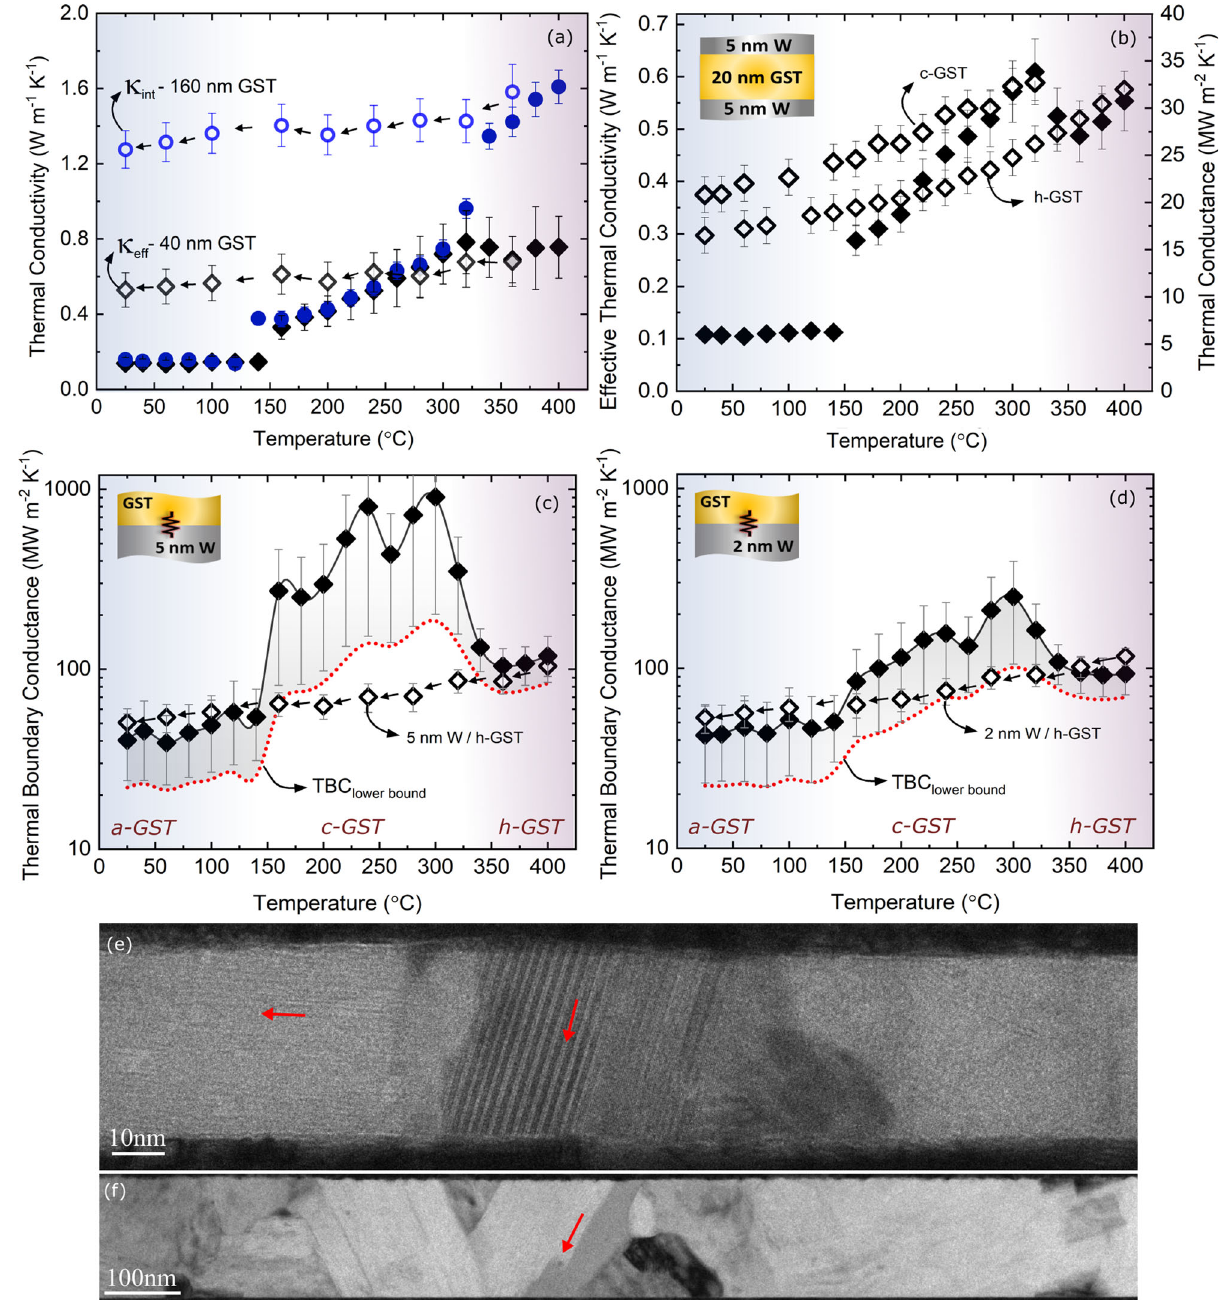
Fig. 3 Thermal properties of GST thin fi lms and interfaces across different phases. a Thermal conductivity of GST layer sandwiched between 5 nm W spacers for 40 nm (diamonds) and 160 nm (circles) GST fi lms. The solid symbols correspond to the thermal conductivity of GST as it transitions through different phases upon heating and hollow symbols correspond to the thermal conductivity of h-GST upon cooling. b Effective thermal conductivity for 20-nm-thick GST fi lm as a function of temperature across different phases of GST upon heating and cooling when annealed to 320 and 400 °C. c , d Thermal boundary conductance for as-deposited GST upon heating and h-GST upon cooling with 5 and 2 nm W spacer, respectively. The error bars are calculated based on 7% uncertainty in the GST fi lm thickness. e , f Bright- fi eld images of 40 and 160 nm GST fi lms at 400